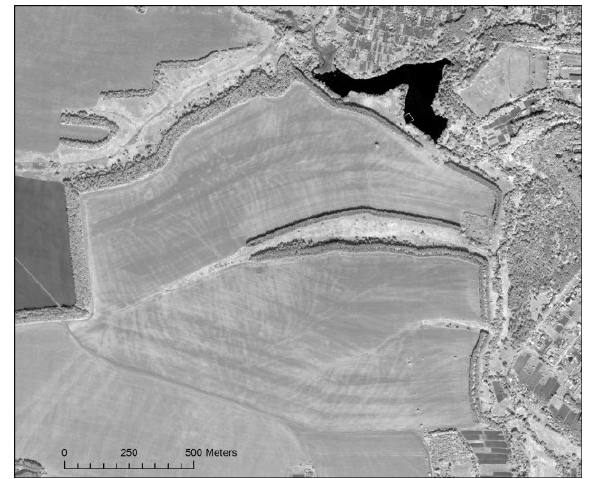
Figure 1. WorldView-2 satellite image of the test area, image collected on May 19, 2012 (image is courtesy of the DigitalGlobe Foundation)